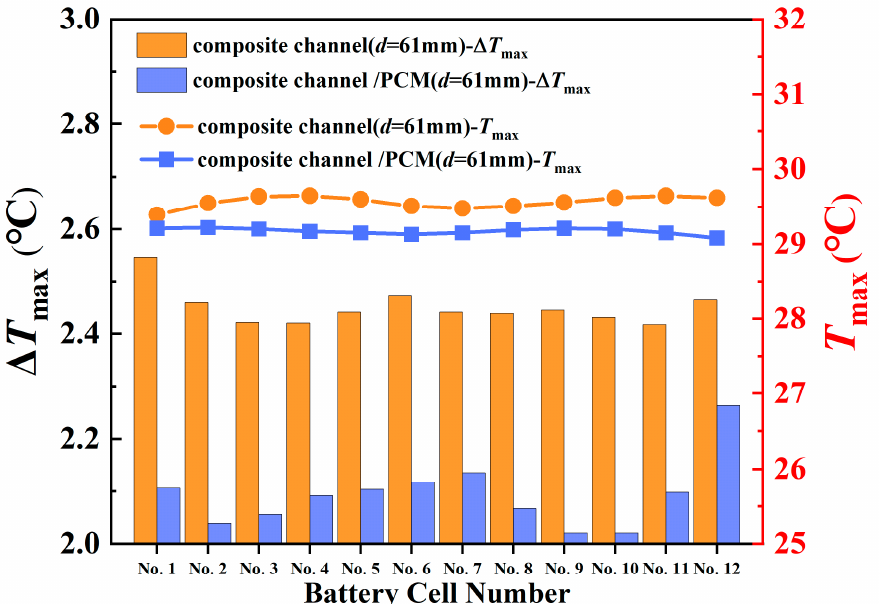
Figure 13. Temperature of composite-channel/PCM